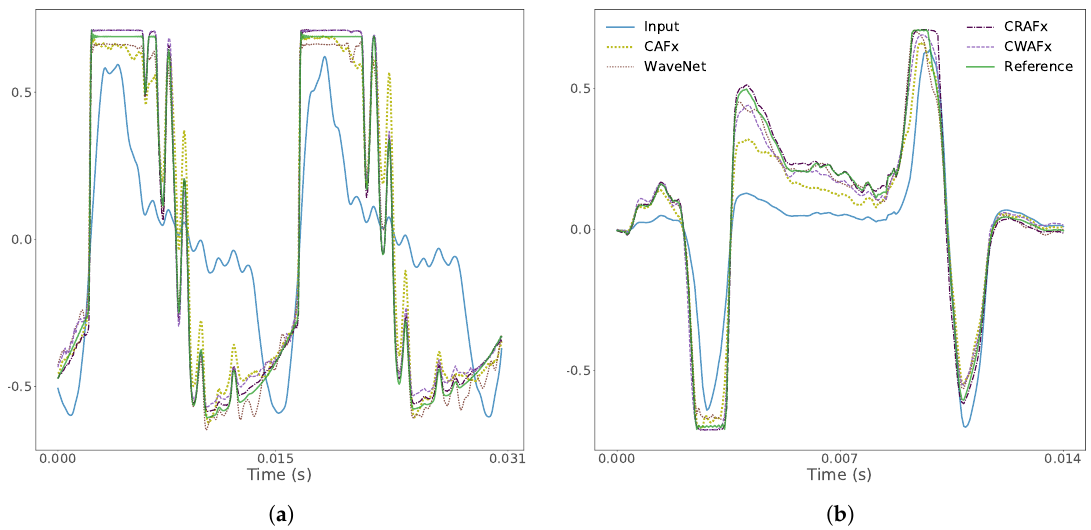
Figure 8. For the test samples from Figure 7, a segment of the respective waveforms: ( a ) preamp task and ( b ) limiter task when processing the onset of the input audio. Vertical axes represent amplitude.